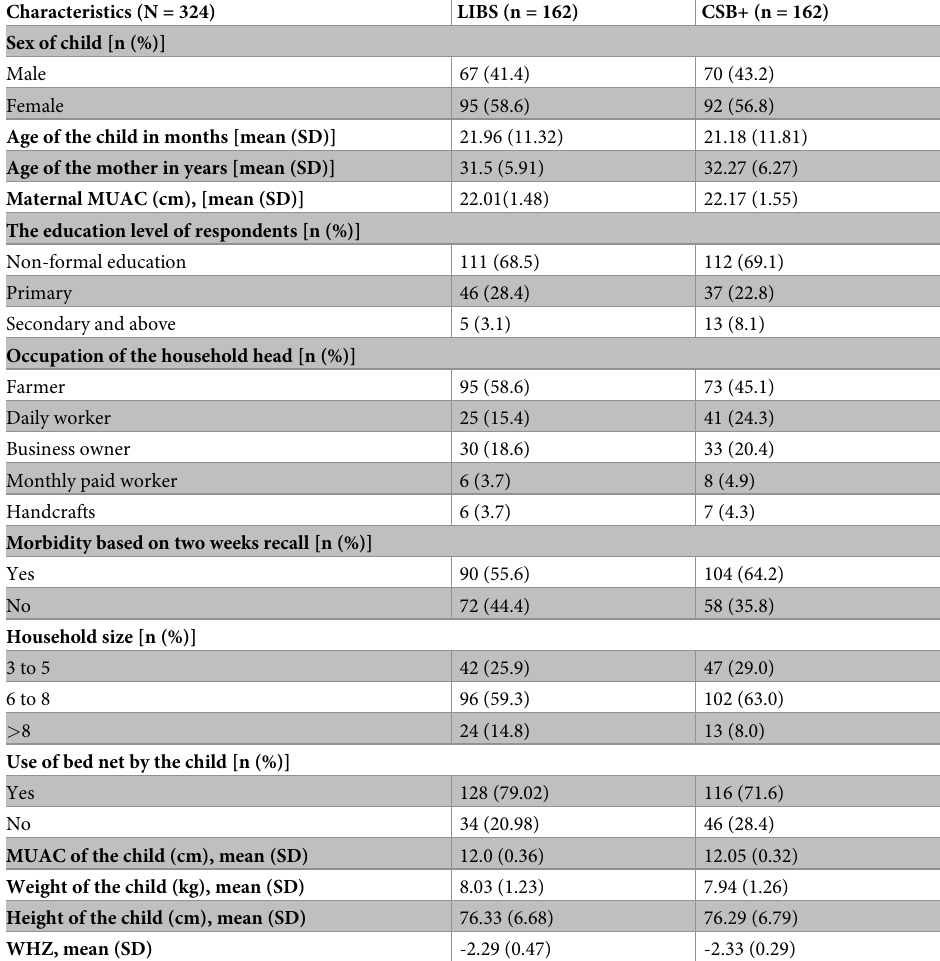
Table 2. Baseline characteristics of study subjects per treatment and control group.